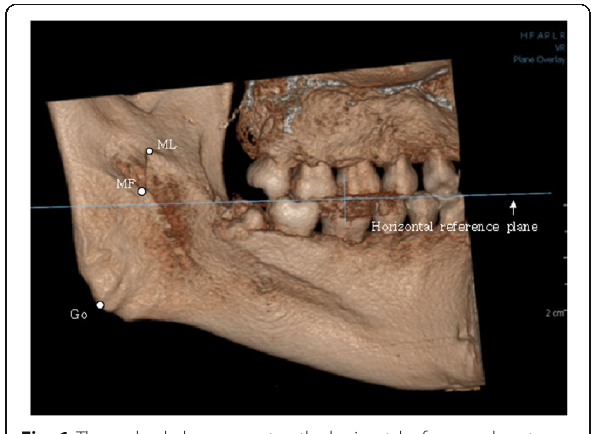
Fig. 1 The occlusal plane was set as the horizontal reference plane to standardize the 3D positions of all the mandible models. (ML, mandibular lingula; MF, mandibular foreman; Go,